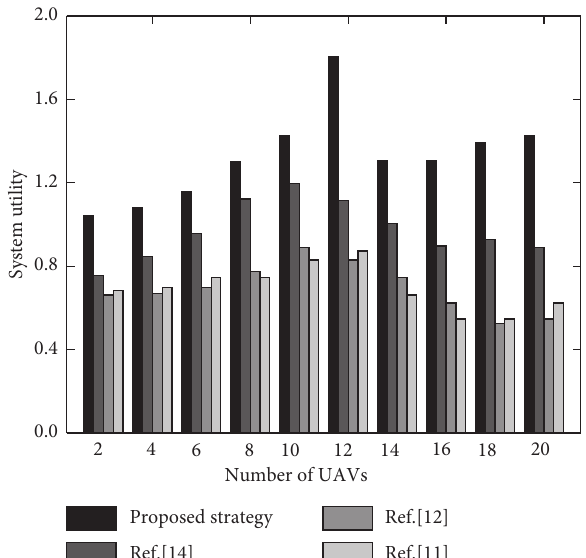
Figure 7: Effect of the number of UAVs on total utility under different strategies.